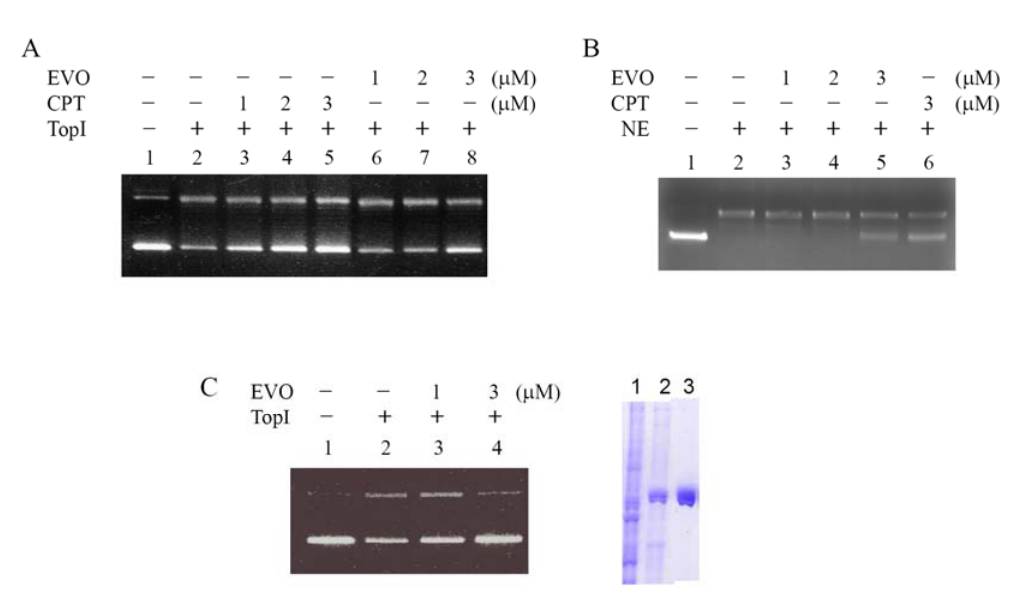
Figure 2. Inhibitory activity of evodiamine (EVO) on topoisomerase I (TopI). (A) Both camptothecin (CPT) and EVO (1~3 μ M) protected DNA from Vaccinia Top I conversion of supercoiled DNA to relaxed closed circular DNA. pCDNA3 (0.2 μ g) plasmid DNA was incubated at 37 °C for 30 min with TopI (0.5 units) from the Vaccinia virus in the presence or absence of 1~3 μ M inhibitors. (B) The reactions with same conditions as adopted in (A) except using nuclear extract (NE) of MCF-7 cells as enzyme source. (C) The same assay conditions as adopted in (A) except using purified recombinant human TopI as enzyme source (left). Recombinant human TopI was obtained using the baculovirus expression system (right, lane 1: cell lysate, lane 2: partial purified fraction, and lane 3: Ni-NTA column purified